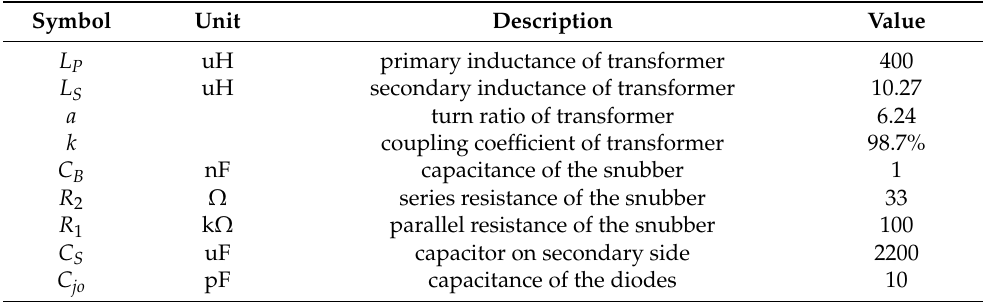
Table 4. Parameters of the flyback